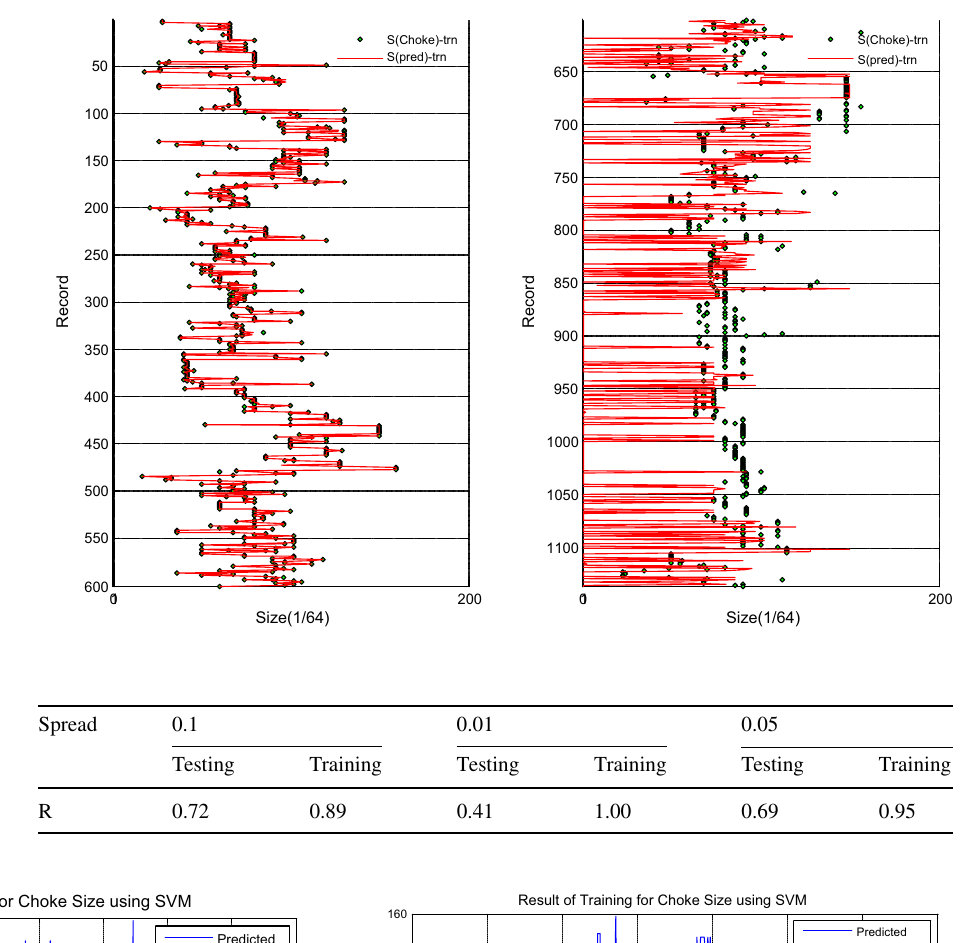
Fig. 19 Correlation between the actual and the predicted choke size for both training and testing data (RBF model for spread = 0.01)